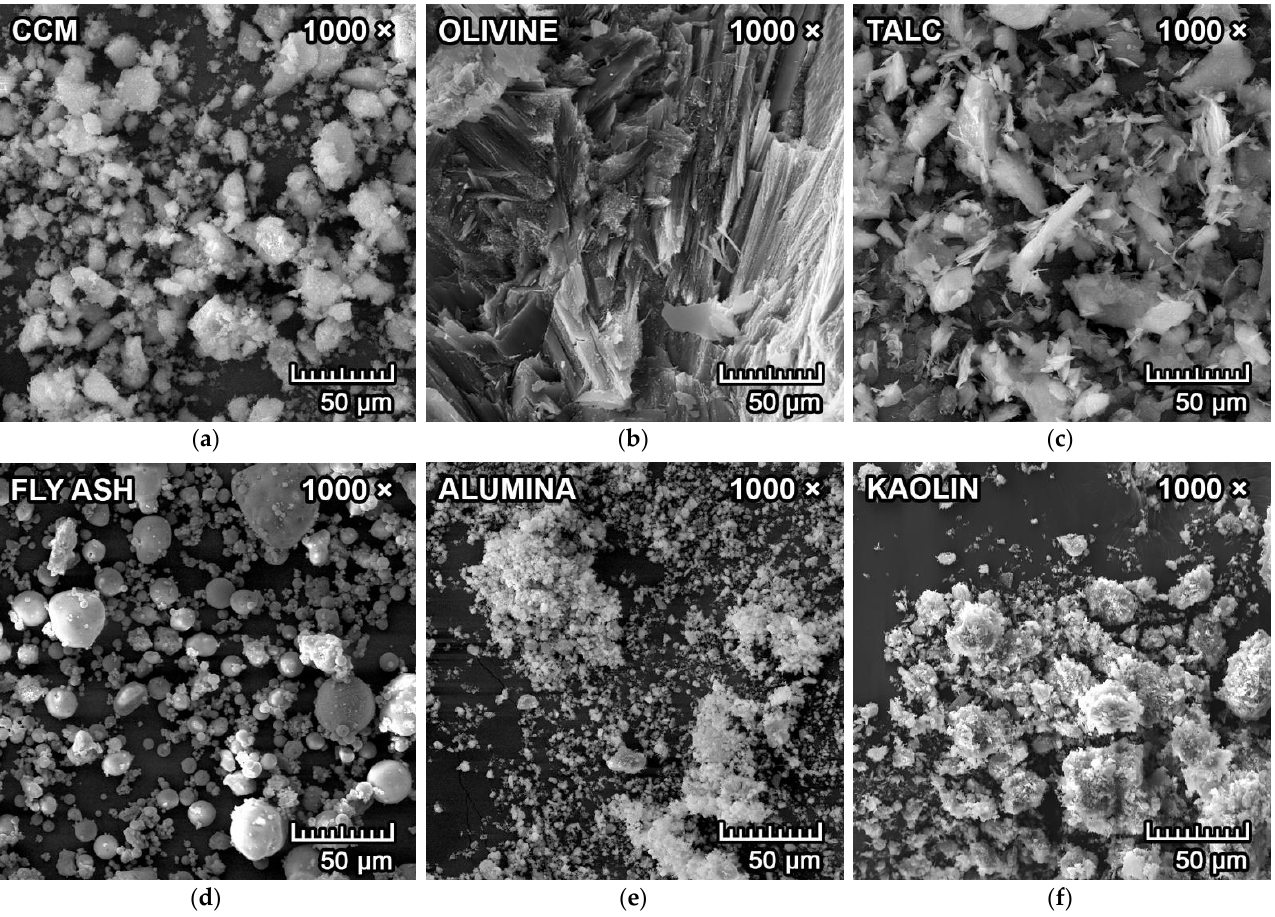
Figure 2. Scanning electron microscope images of ( a ) CCM; ( b ) olivine; ( c ) talc; ( d ) fly ash; ( e ) alumina; ( f ) kaolin with 1000× magnification.